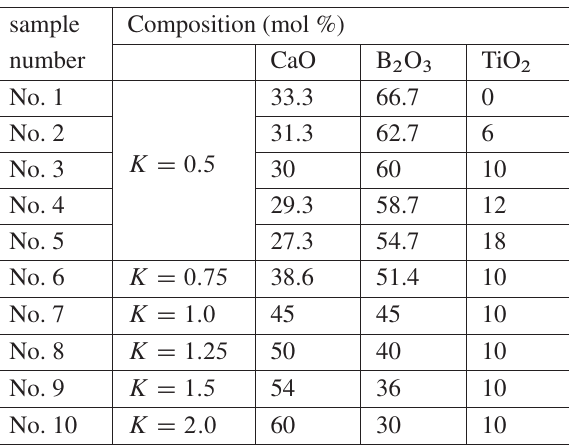
Table 1. Oxide compositions of experimental samples.